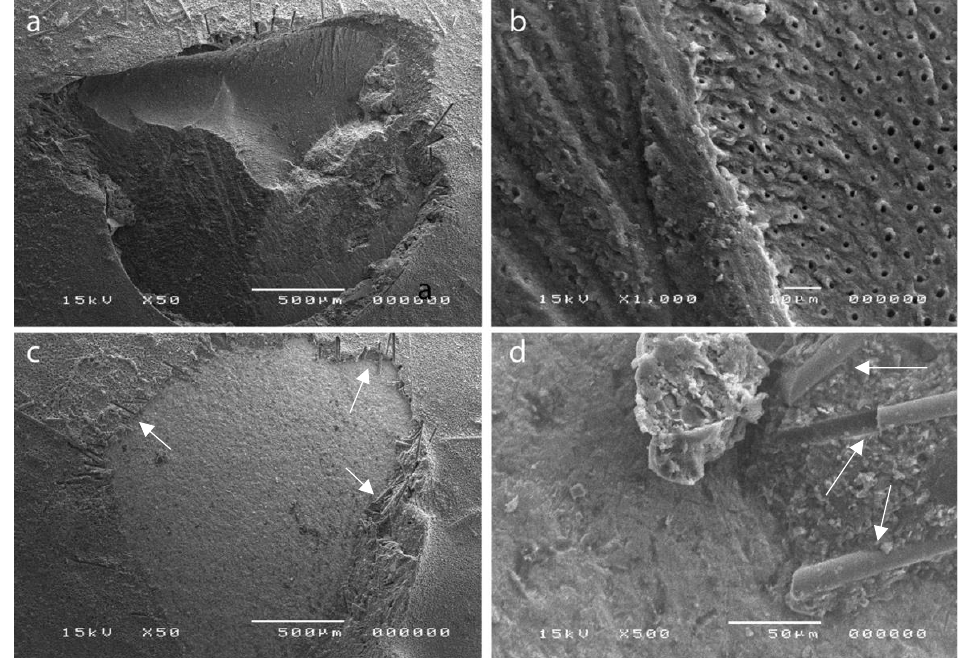
Figure 6. CBC prototype and detachment sites of the cylinders after the mSBS tests: ( a , b ) mixed adhesive and cohesive fractures on dentin; ( c , d ) adhesive fractures on zirconia with short glass fibers of about 14 µm in diameter clearly visible (white arrows).